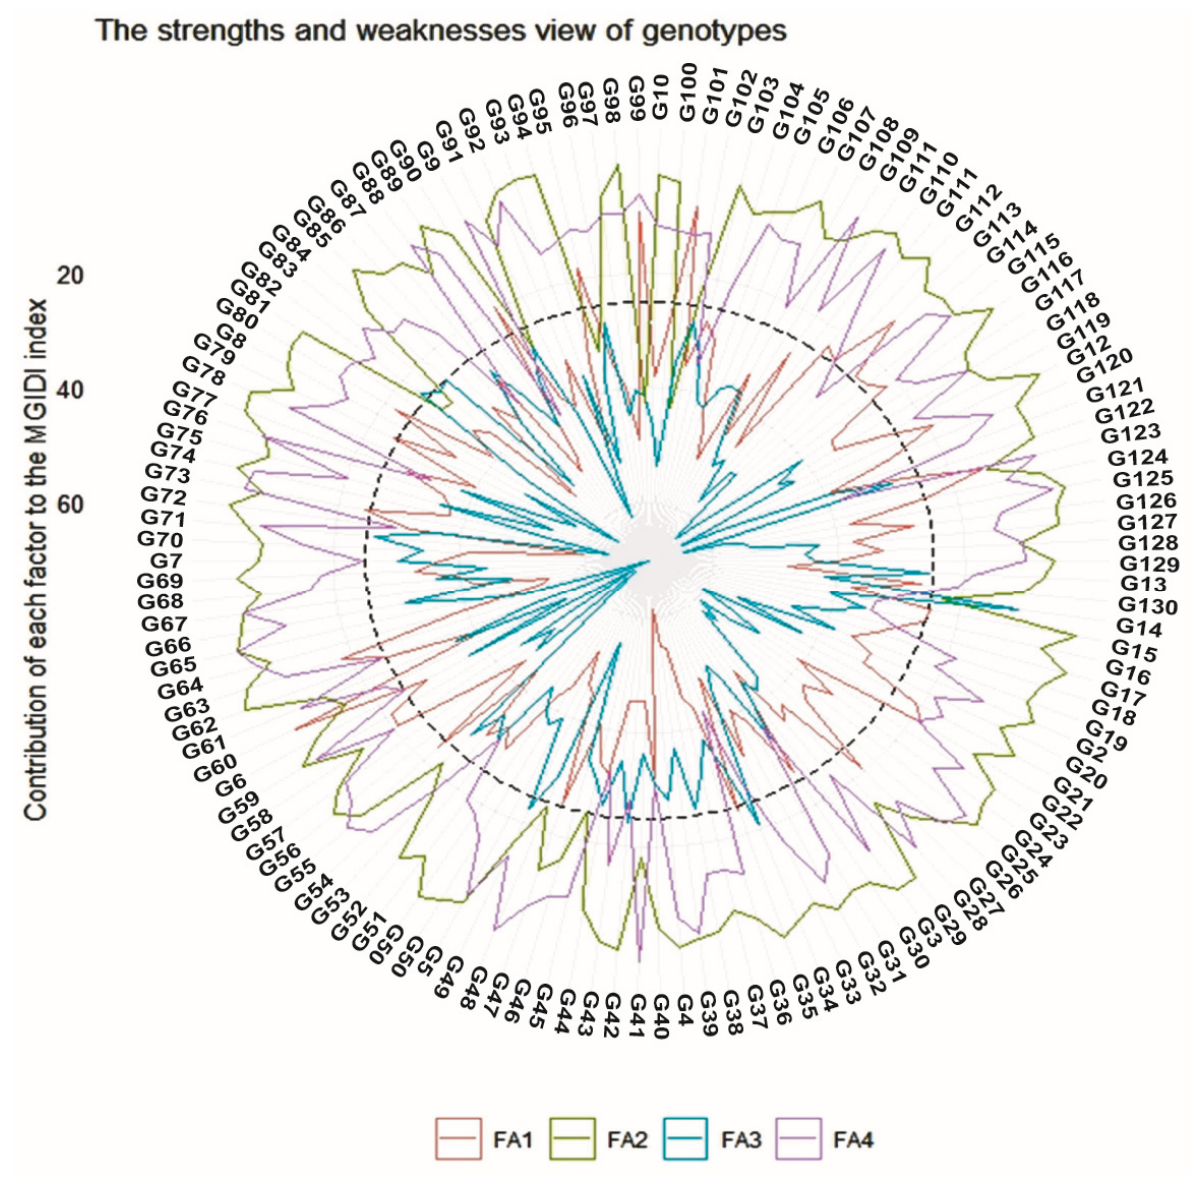
Figure 7. The strengths and weaknesses of all the genotypes.